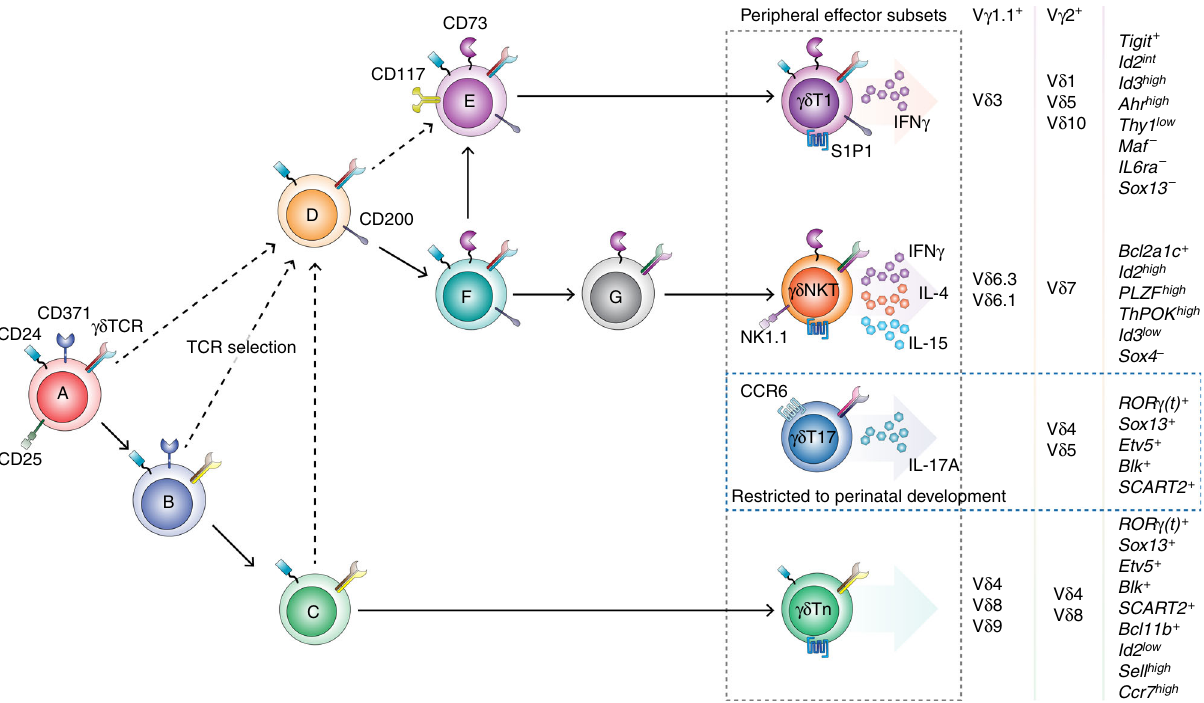
Fig. 7 γδ Tn, γδ T1 and γδ NKT cells develop through three distinct pathways in the adult thymus. Suggested model of γδ T cell development divided into the A to G stages de fi ned by the expression of CD117, CD200 and CD371 together with CD24, CD25 and CD73. The A stage de fi nes the earliest γδ TCR- expressing progenitors, which develop towards the B and C populations and eventually result in the export of TCR-naive adaptive γδ T cells ( γδ Tn). Encounter with cognate TCR ligands induces TCR selection, shifting the cells to progress through the D and F stages. TCR-selected γδ thymocytes will then progress to the E or G stage, resulting in the export of IFN- γ -producing ( γδ T1) or IFN- γ /IL-4-co-producing ( γδ NKT) cells, respectively. The C, E and G stages are characterised by the distinct expression of key factors involved in effector programming, including characteristic transcription factor networks and cytokines, and display highly focused TCR V δ repertoires. IL-17-producing ( γδ T17) cells do not develop in the adult thymus, but long-lived resident γδ T17 cells are included in the G population at homoeostasis and can be distinguished by their expression of